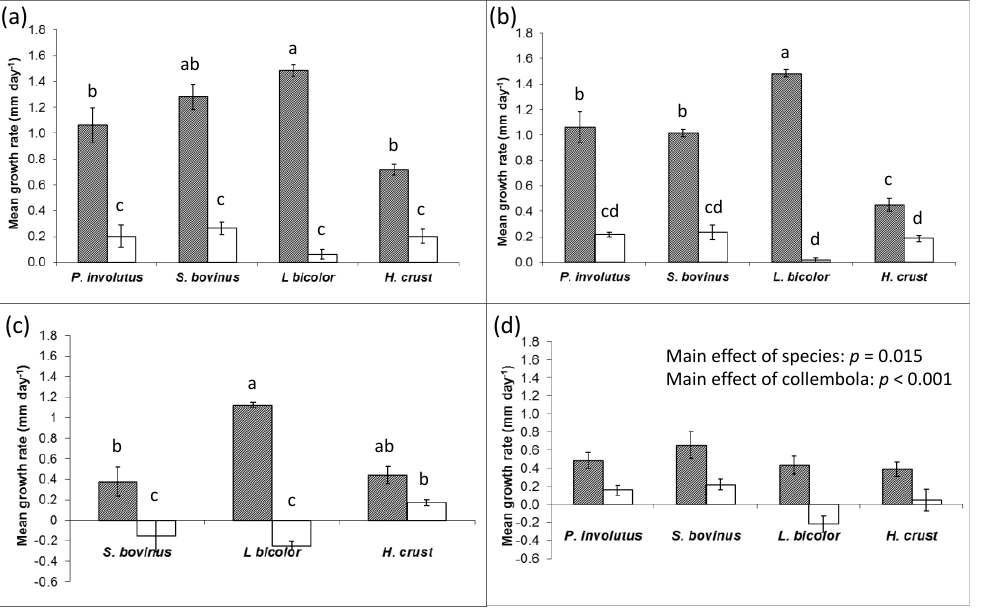
Figure 1. Radial extension of selected ECM fungi in pure culture in the absence (shaded) or presence (open) of collembola (±SEM, n = 4). ( a ) Single species cultures and ( b ) mixed species cultures in the early, establishing phase of growth; and ( c ) single species cultures and ( d ) mixed species cultures in late, established phase of growth. Bars sharing a letter are not significantly different ( p > 0.05).